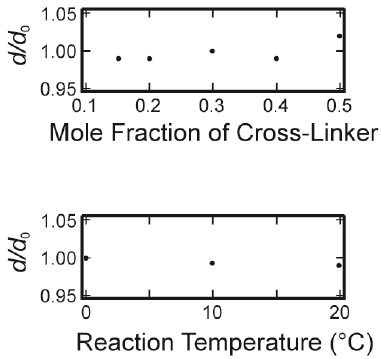
Figure 4. The equilibrium swelling ratio of opaque gels. The swelling ratio is plotted as a function of the mole fraction of the cross-linker in the upper figure. The reaction temperature is fixed at 20 °C. In the lower figure, the swelling ratio is plotted as a function of the reaction temperature. In this series, the mole fraction of the cross-linker is fixed at 0.2. Here, d is the diameter of the cylindrical gel in the equilibrium state that is gelled in a capillary of an inner diameter of d 0